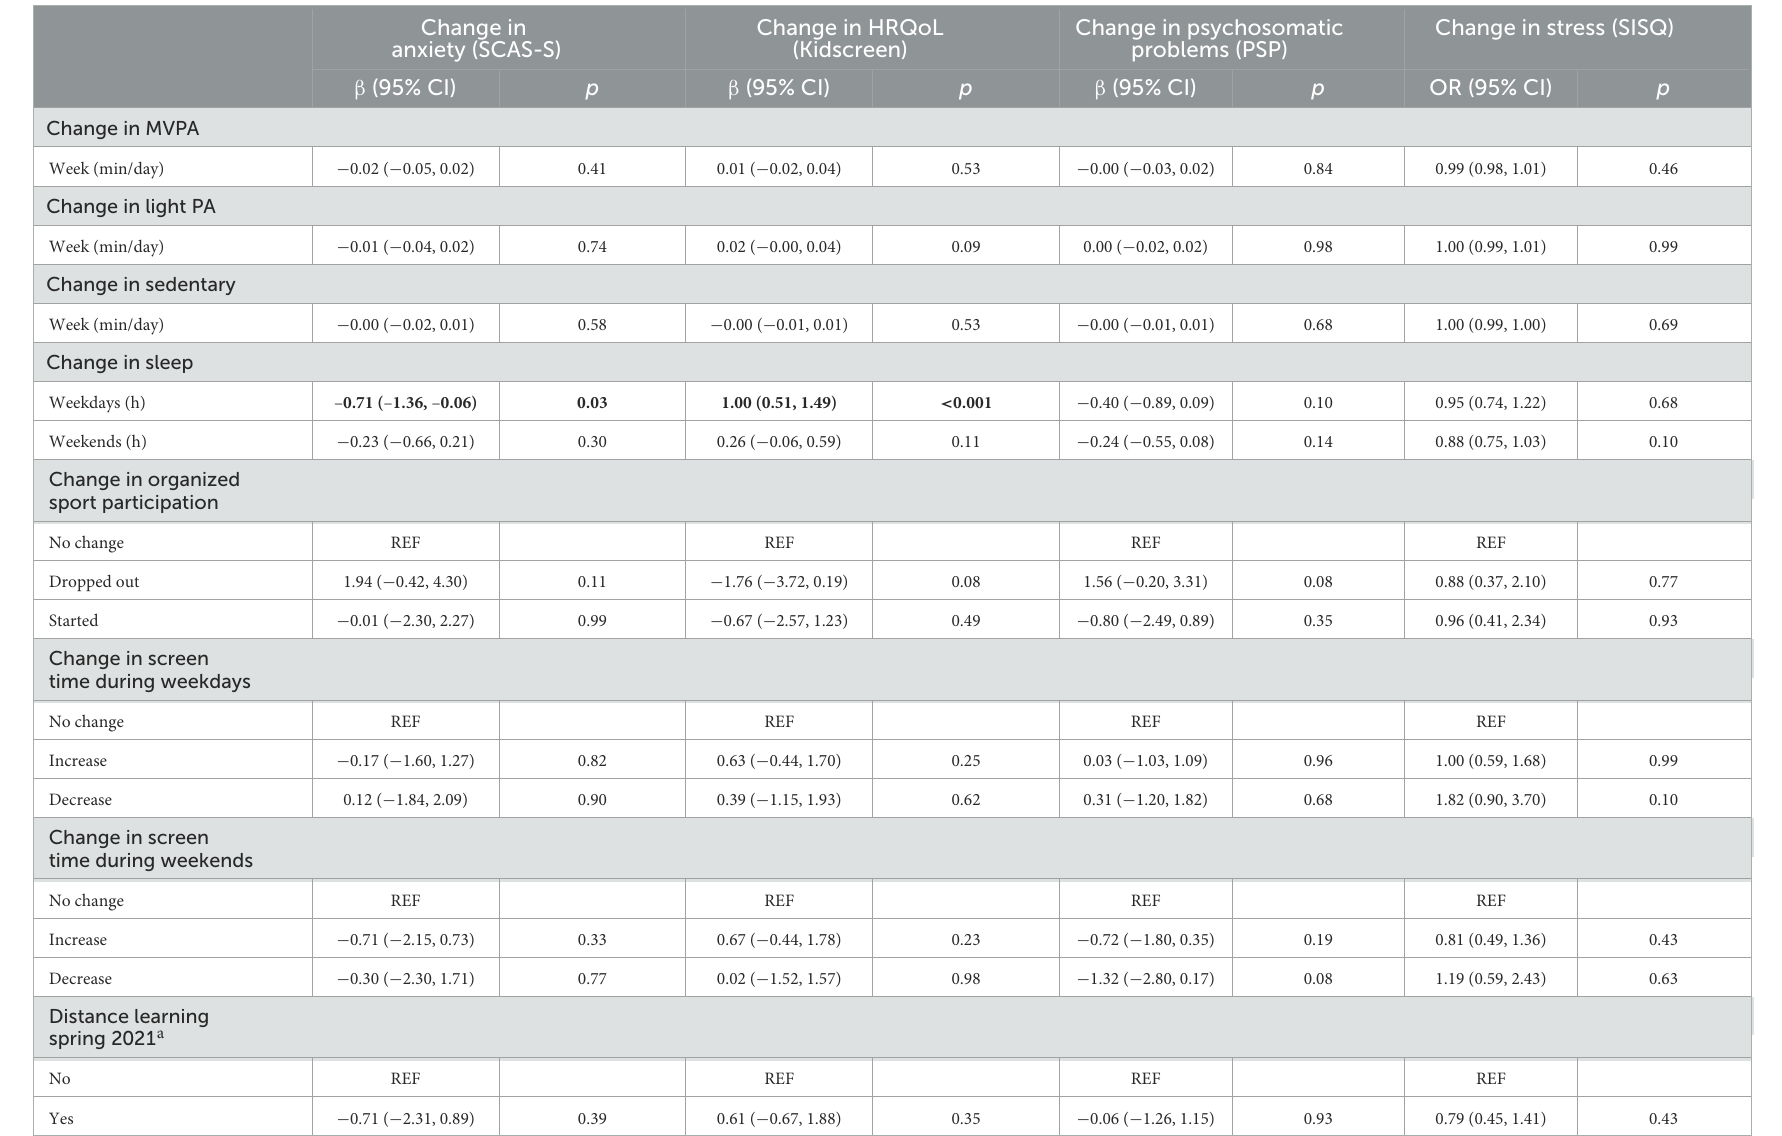
TABLE 4 Relationships between changes in physical activity, sedentary time, and health behaviors, from baseline to follow-up.